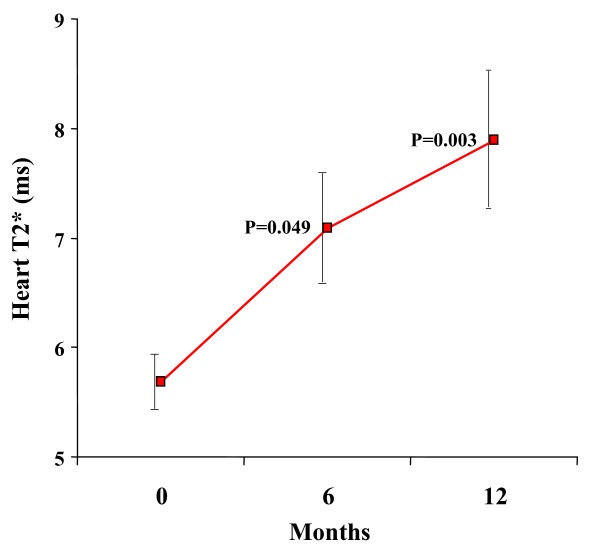
Myocardial T2* improved significantly between baseline and 12 months. Standard error bars are shown. The p values shown are post-hoc analyses for 0–6 months, and 0–12 months.